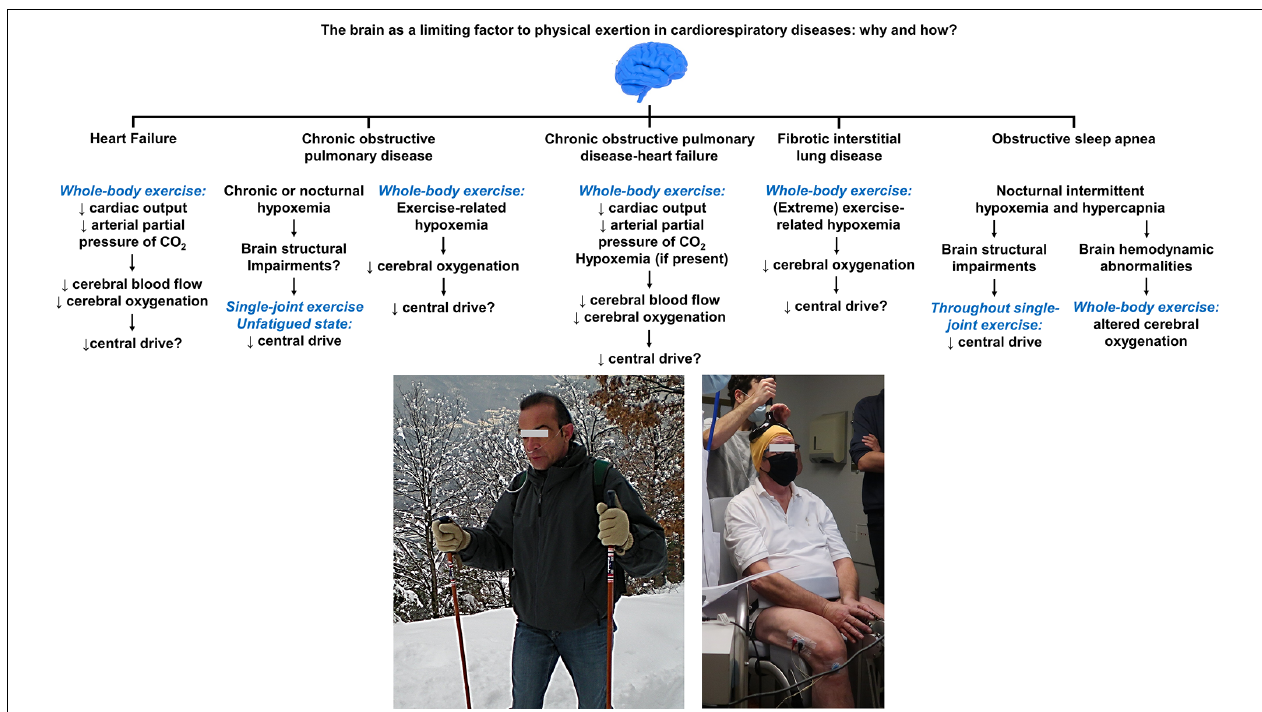
FIGURE 6 | Summary of the mechanisms by which the brain may act as a limiting factor to physical exertion in cardiorespiratory diseases. Compromised cerebral oxygenation during whole-body exercise, owing to poor brain perfusion and/or exercise-related hypoxemia (e.g., a patient with chronic obstructive pulmonary disease requiring supplemental O 2 , left picture ), appears as a common denominator in such diseases. Supporting evidence for the deleterious influence of impaired cerebral oxygenation on central/supraspinal fatigue (using transcranial magnetic stimulation, right picture ) during exercise are, nevertheless, currently lacking in most of the showcased conditions. Despite deficits in cerebral perfusion during exercise in patients with heart failure, no study to date has established the contribution of central fatigue to limit patient’s ability to sustain prolonged exercise. Deficits in voluntary activation from the motor cortex in unfatigued state have been shown in specific subpopulations of patients with chronic obstructive pulmonary disease, whose implications upon exertion are uncertain. It remains also unknown whether impaired cerebral O 2 delivery translates into exaggerated manifestations of central fatigue in patients with chronic obstructive pulmonary disease-heart failure. Exertional hypoxemia impairs cerebral oxygenation in a dose-dependent fashion in fibrotic interstitial lung disease. In light of the unparalleled severity of hypoxemia observed in this patient population, cerebral hypoxia likely holds an independent impact on the descending motor drive although this remains to be spelt out. Lower cortical drive to the active muscles during single-joint exercise have been shown in severe obstructive sleep apnea and may contribute to skeletal muscle dysfunction; the repercussions of these findings during whole-body exercise are uncertain although the cerebral hemodynamic response to incremental cycling relates to exercise capacity in these patients. Future mechanistic studies may focus on investigating the potential neuromuscular consequences of the featured (and other hitherto unexplored) cardiorespiratory conditions in whom fatigue is typically a major complaint during daily physical